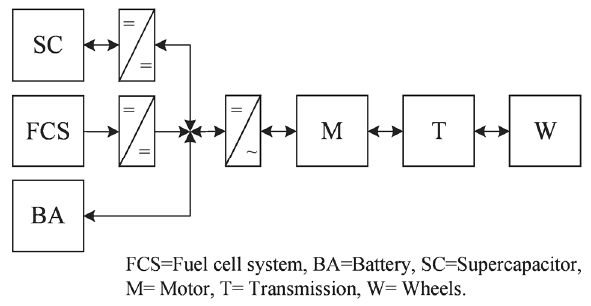
Figure 1. Schematic of fuel cell/battery/supercapacitor hybrid drive